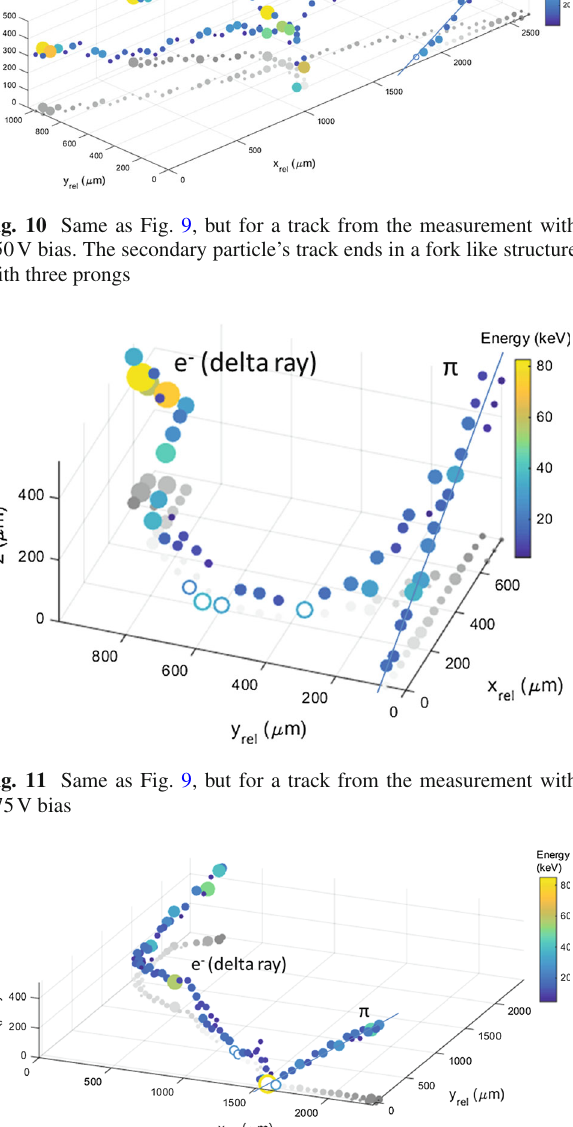
Fig. 9 3D reconstructed 120GeV/c pion track with outgoing delta ray from the measurement with 130V bias. The primary pion track passes throughthesensitivevolumealmostundeflected,whereasthesecondary electron undergoes multiple scattering along its path. The energy depo- sition in each pixel is indicated by color and corresponds linearly to the radius of the circles . The projection in the xy -plane depicts the z -coordinate in gray scale . To better illustrate the dimensions of the tracks, the sensitive volume was cropped to the region of interest and relative coordinates were calculated